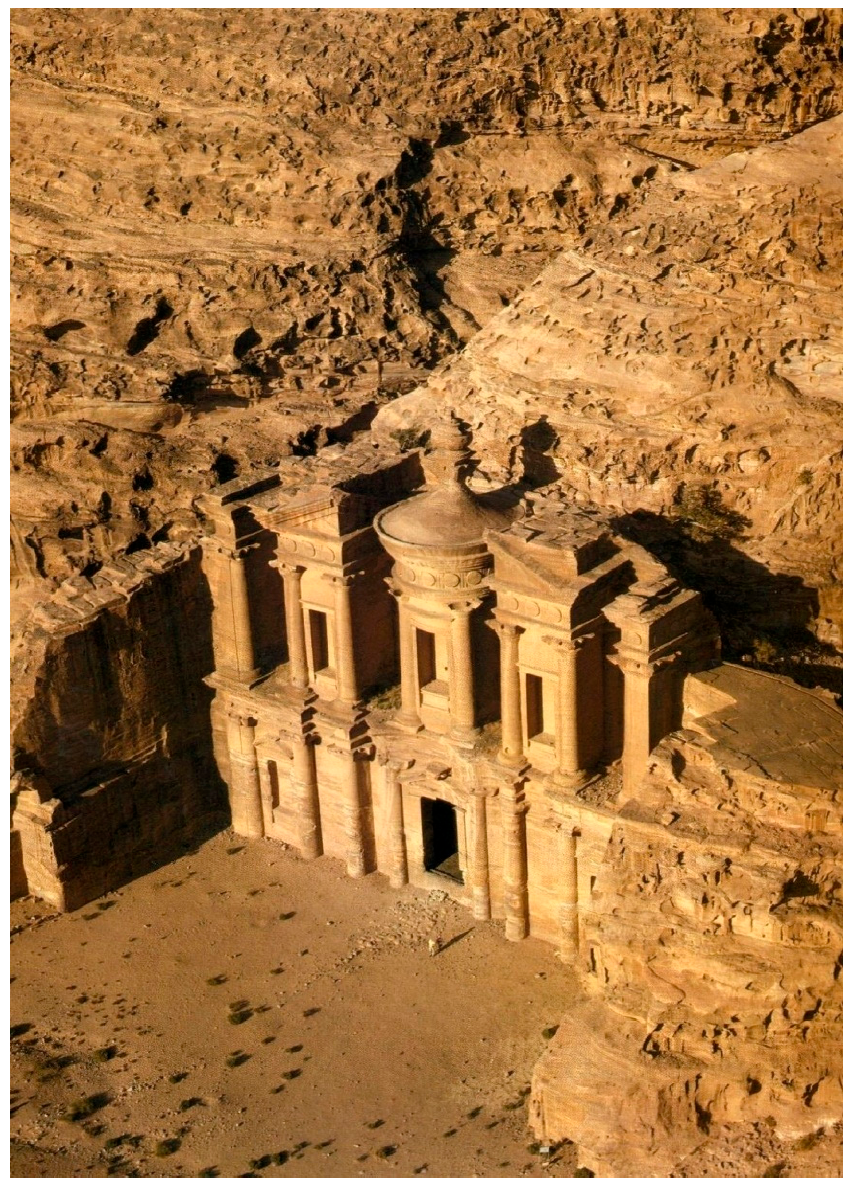
Figure 22. The Monastery Temple.